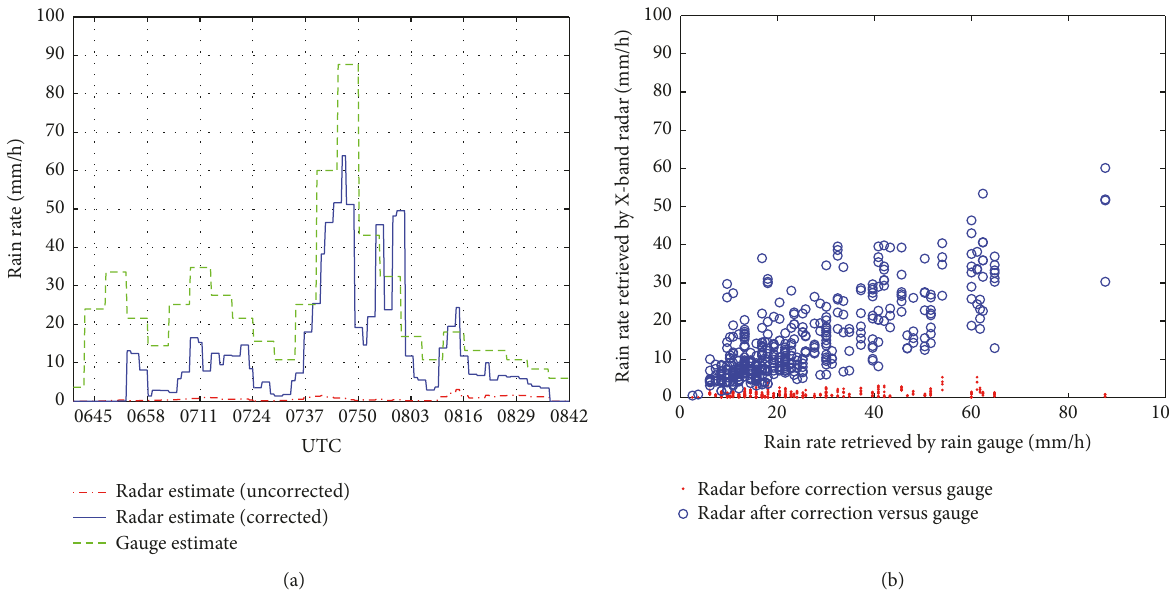
Figure 12: (a) Comparisons of rain rates derived by the XR reflectivity before correction, the XR reflectivity corrected with ACML method, and gauge 3 during 0640 to 0842 UTC, 2 June 2015. (b) Scatter plot of rainfall retrieved by the XR against rainfall retrieved by gauges 1 to 6 during the same period as